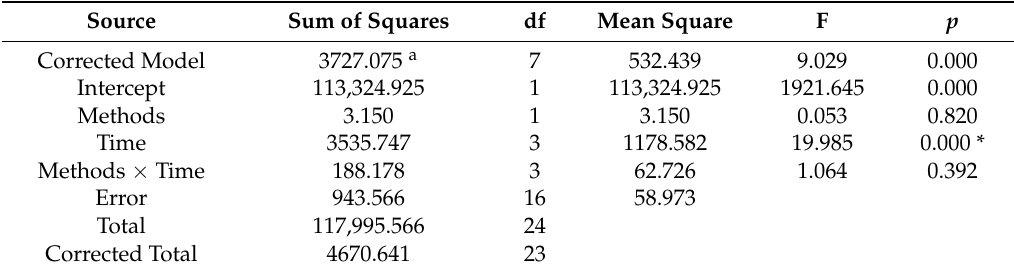
Table 4. Effects of different seed collection time and methods on the germination of Ginkgo biloba ‘Jiafozhi’.